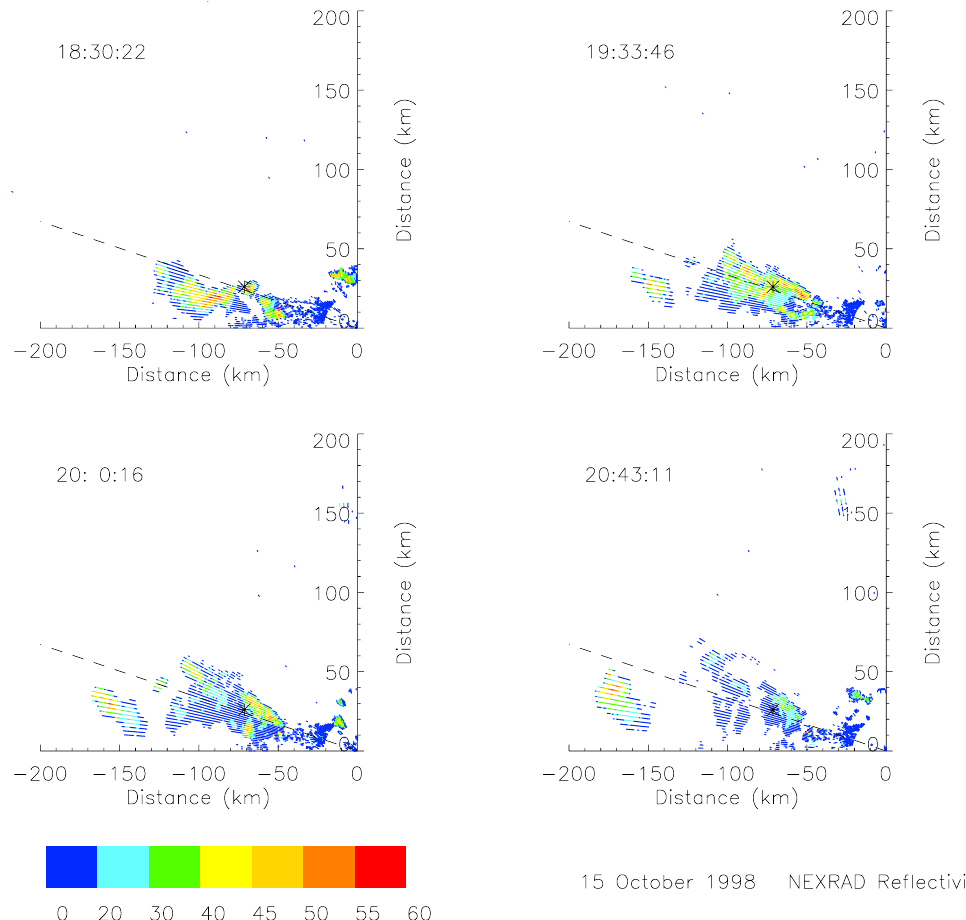
Fig. 1. Horizontal display of the NexRad reflectivity (dBZ) in color scale at an elevation of 0.4 ◦ observed in the northwest quadrant at different lifetimes of the